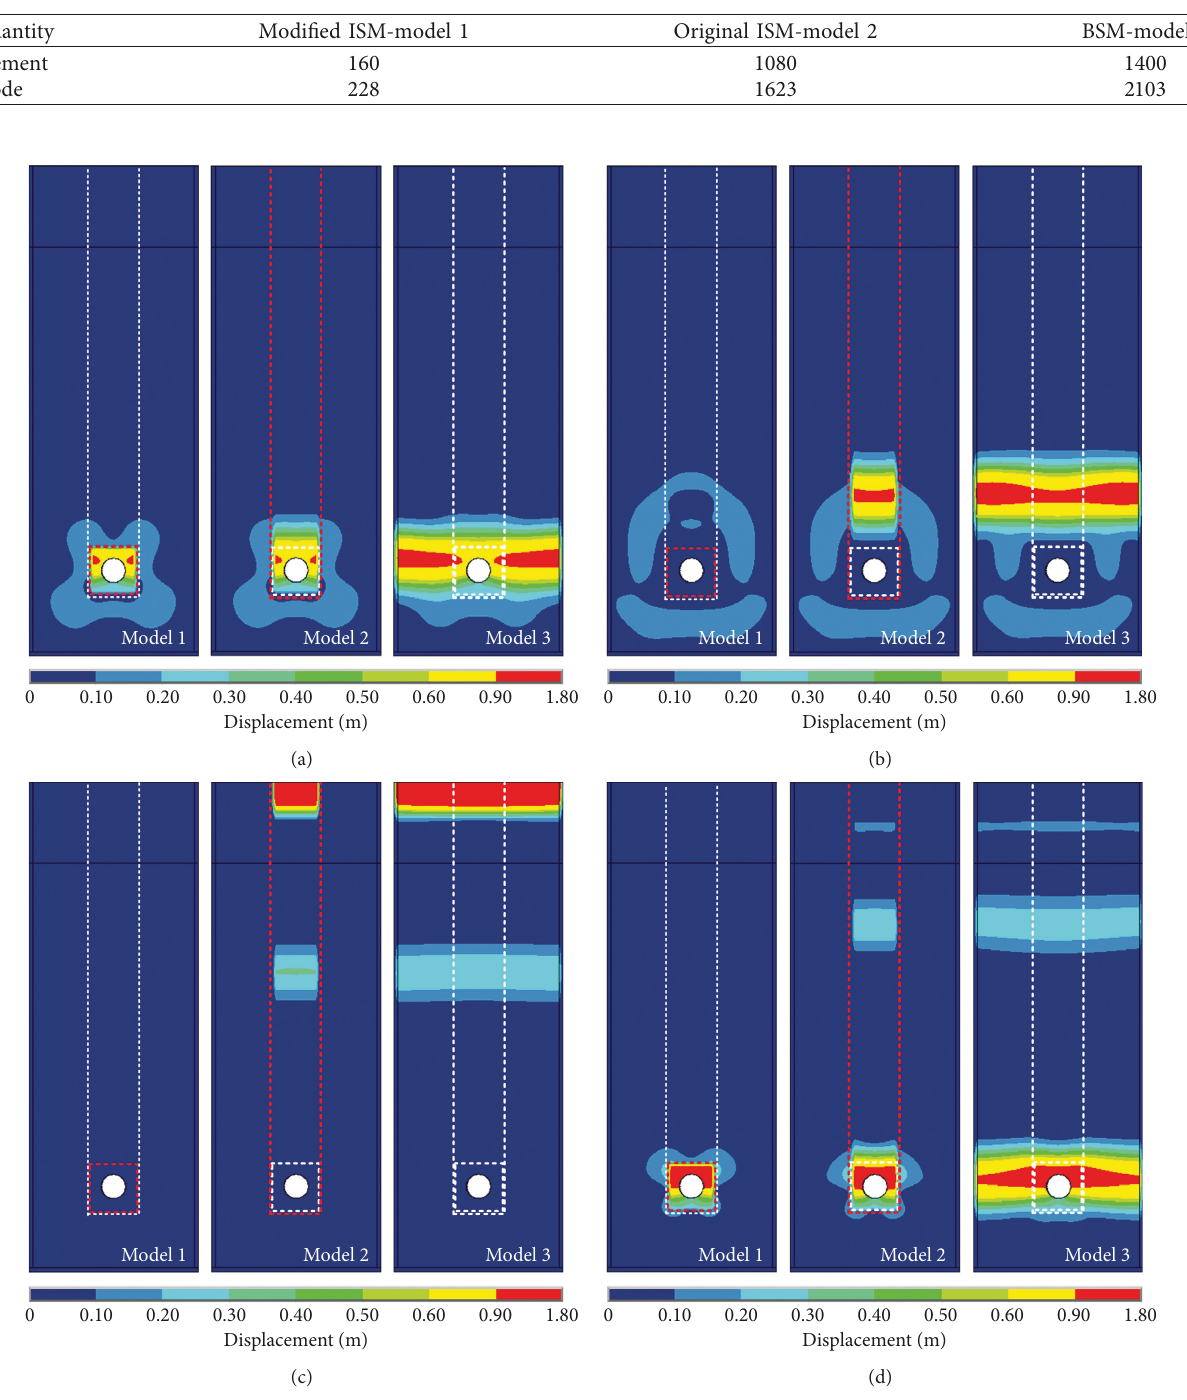
Figure 12: Snapshots of the layered half-space model with a deep underground cavity: (a) t � 0.25s, (b) t � 0.35s, (c) t � 0.90s, and (d) t � 1.62